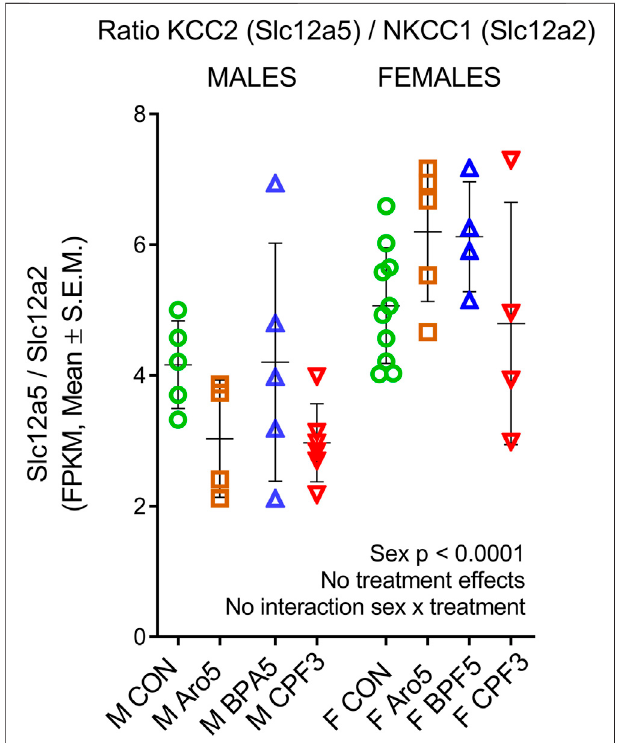
FIGURE 1| Epression ratio of potassium-chloride-co-transporter KCC2 (Slc12a5), neuron-speci fi c chloride ion extruder, to sodium-potassium- chloride-co-transporter NKCC1 (Slc12a2), increasing intracellular chloride concentration,inindividualhippocampussamplesofmaleandfemalerat offspring at postnatal day 6. RNAseq data, ratio of FPKM (fragments per kilobase per million reads), mean ± SD and individual samples (M, male, F, female). Two way ANOVA, sex difference ( p < 0001), but no treatment effects and no sex × treatment